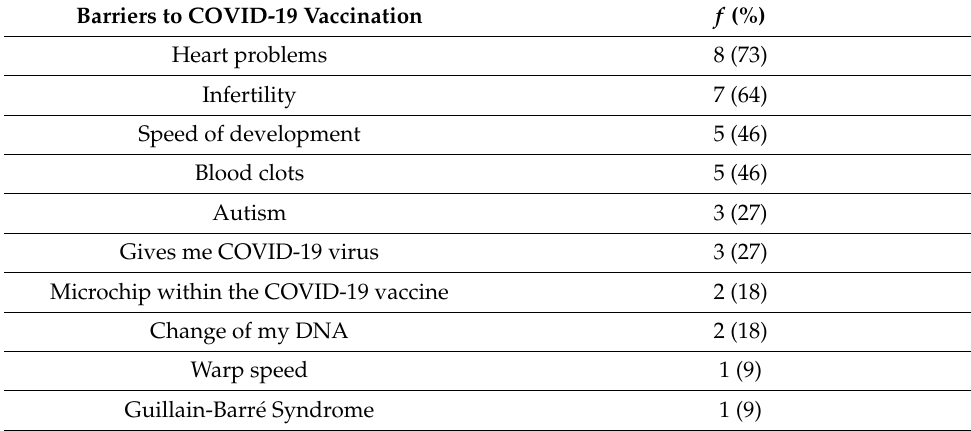
Table 4. Self-reported barriers to COVID-19 vaccination among the unvaccinated participants ( n = 14). Barriers to COVID-19 Vaccination f (%) Heart problems 8 (73) Infertility 7 (64) Speed of development 5 (46) Blood clots 5 (46) Autism 3 (27) Gives me COVID-19 virus 3 (27) Microchip within the COVID-19 vaccine 2 (18) Change of my DNA 2 (18) Warp speed 1 (9) Guillain-Barr é Syndrome 1